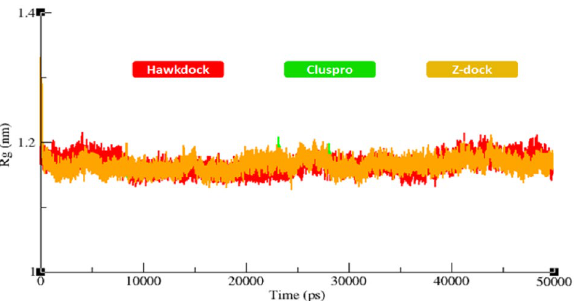
Figure 10. Rg of all the docked structures from three docking servers during 50000 ps simulation.